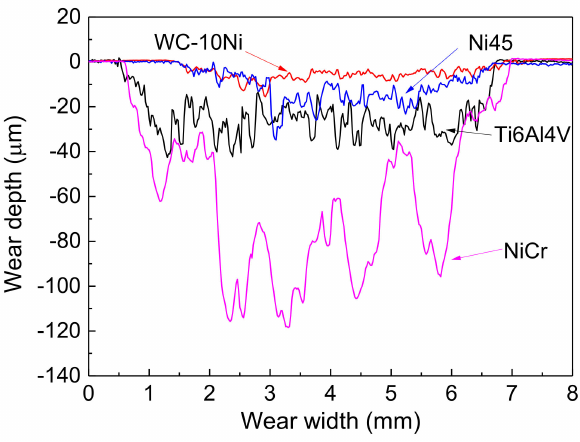
Figure 8. Cross-sectional wear trace of Ti6Al4V alloy and